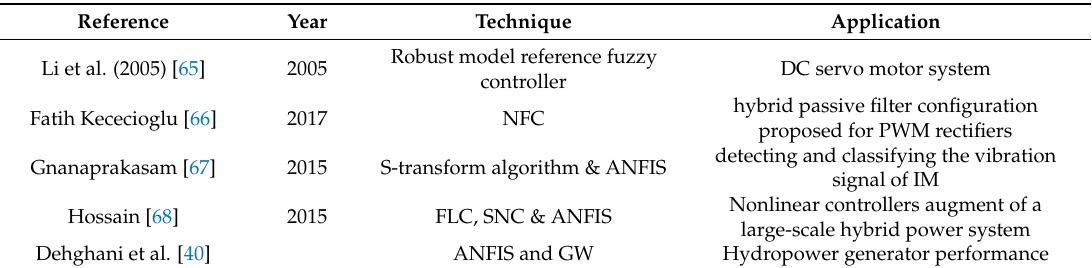
Table 3. Hybrid techniques applied in electrical machine design and control.